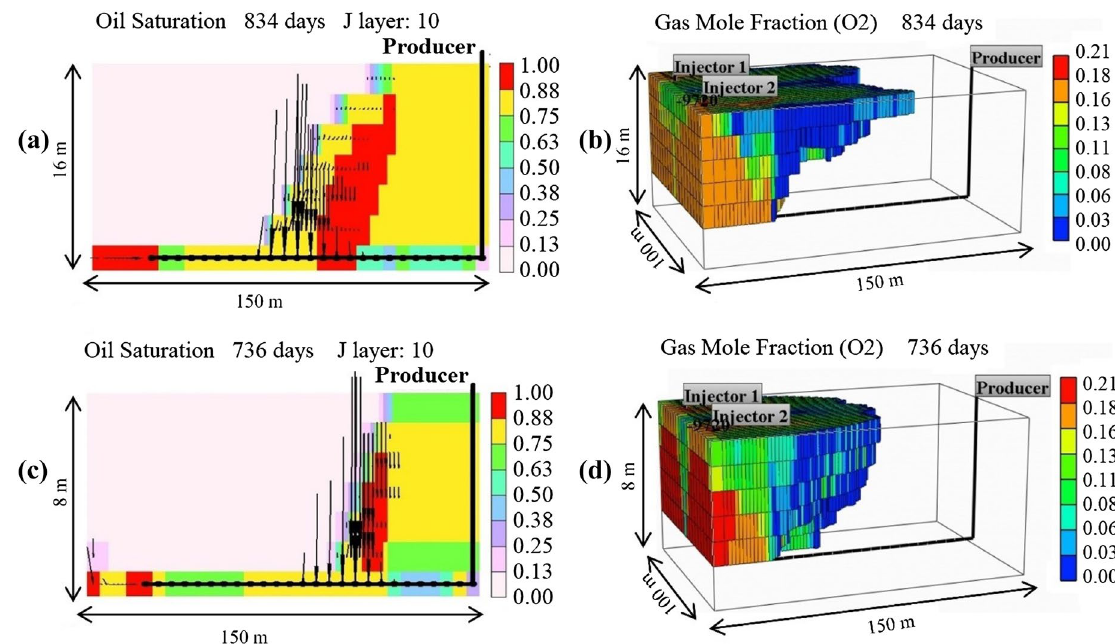
Fig. 8 Oil saturation profiles along vertical mid-plane (left) and 3D shape of combustion front (right) for the constant air injection flux